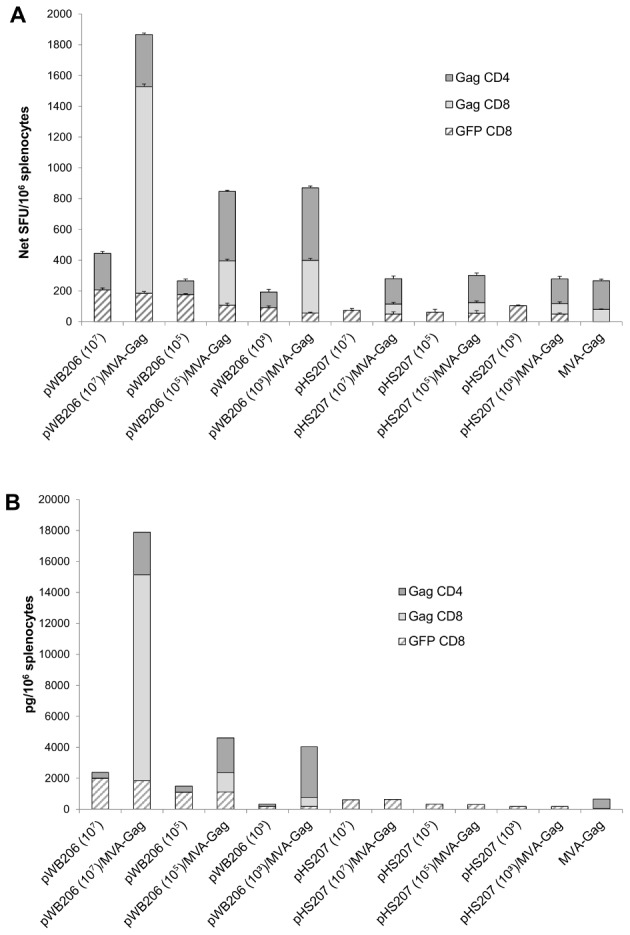
rBCG prime and MVA-Gag boost immune responses.Mice were primed with BCG[pWB206] or BCG[pHS207] (intraperitoneal vaccination; doses of 107 CFU, 105 CFU, 103 CFU) or left unprimed, then boosted on day 56 with MVA-Gag (intramuscular vaccination, 107 pfu). Splenocytes pooled from a group of 5 mice were used on day 68 in A. an IFN-γ ELISPOT assay with the GFPCD8 peptide, GagCD8 peptide or GagCD4 peptide. Bars represent the average number of SFU/106 splenocytes ± the standard deviation of triplicate reactions after subtraction of average background responses of not more than 20±10 SFU per 106 splenocytes. B. Splenocytes were cultured (48 h) with the GFPCD8 peptide, GagCD8 peptide or GagCD4 peptide and cytokine levels in the culture supernatant were quantified using a Th1/Th2 cytokine bead array assay and flow cytometry. Only IFN-γ was detected in the culture fluid. Levels are expressed as pg/106 splenocytes and are from a representative experiment.